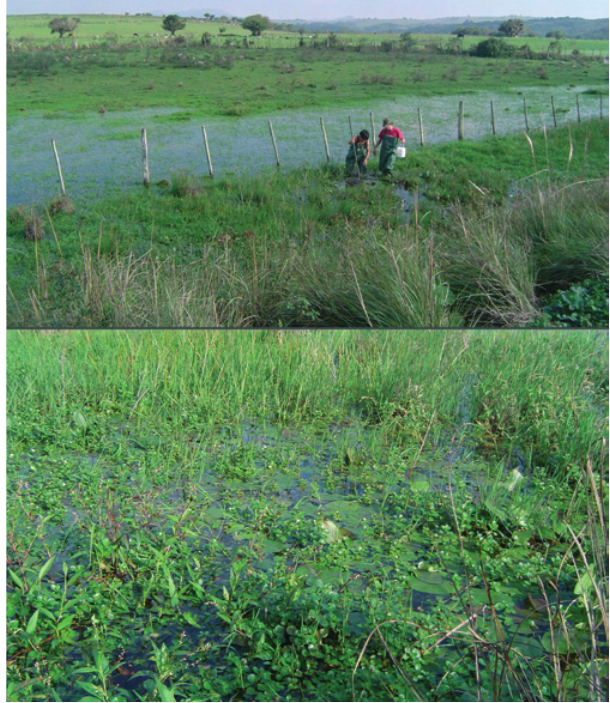
Fig. 5. Temporary pool close to BR290 highway (30°22’27”S 53°33’42”W), type locality of Austrolebias paucisquama (above) and detailed image of the vegetation